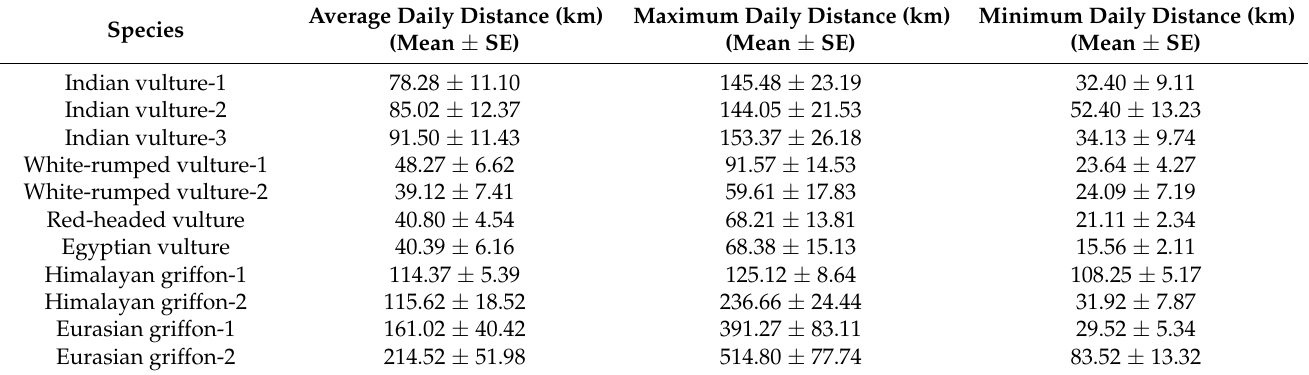
Table 3. Average (mean ± SE) daily distances travelled by satellite-tagged